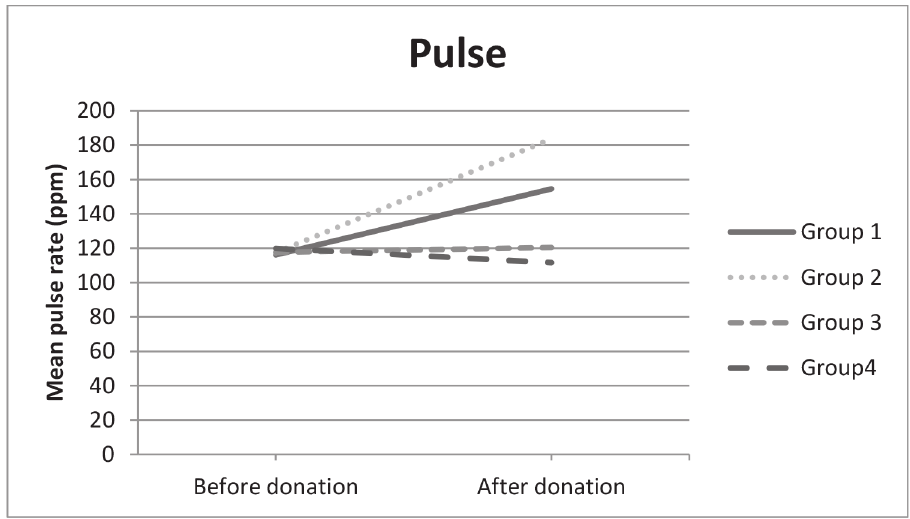
Figure 1 - Mean pulse rates evidenced before and after the blood collection in each